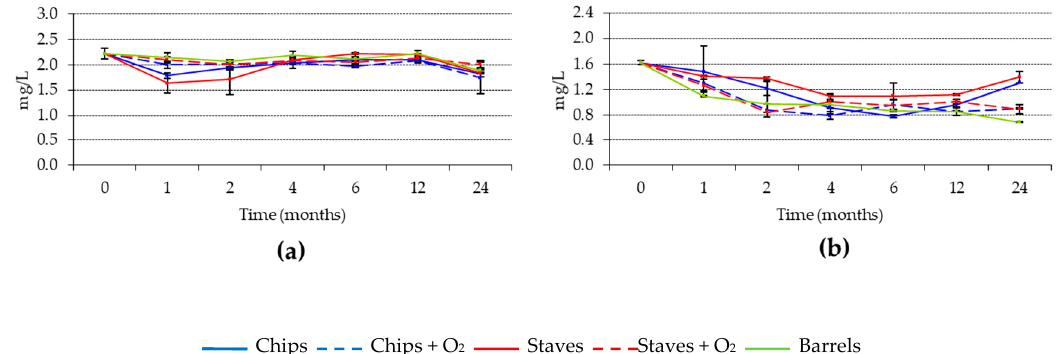
Figure 8. Evolution of stilbenes concentration (mg/L) over time: ( a ) trans -piceid; ( b ) trans -resveratrol. Mean ± standard deviation ( n = 2).